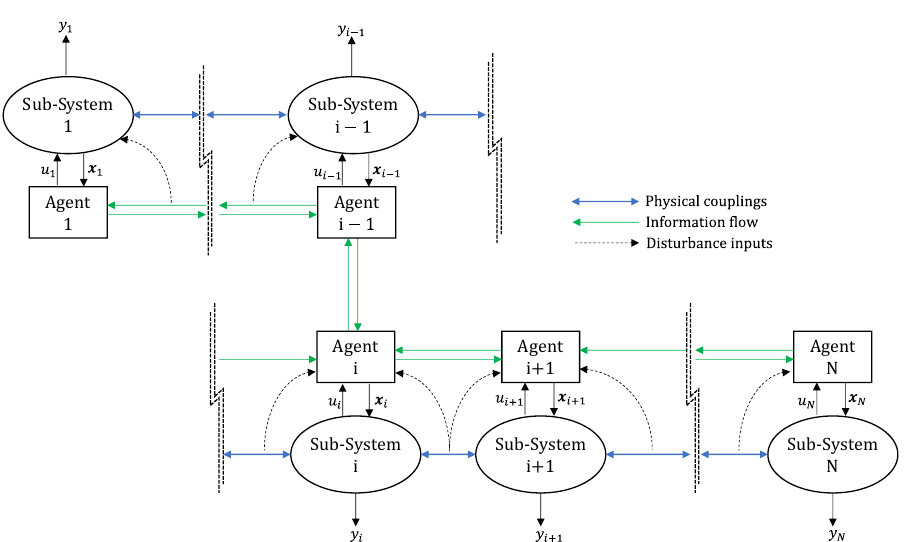
Figure 4. Decomposition of a large-scale dynamic system using agent-based control.